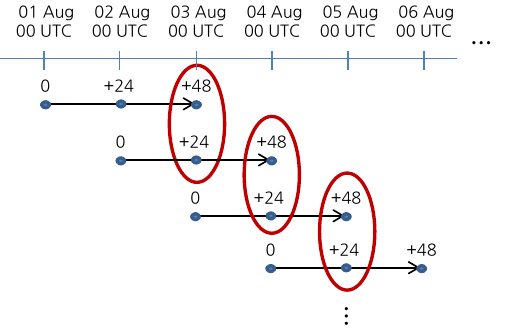
Figure 9. Schematic illustration for the NMC approach to obtain the background error covariance (BEC) matrix.